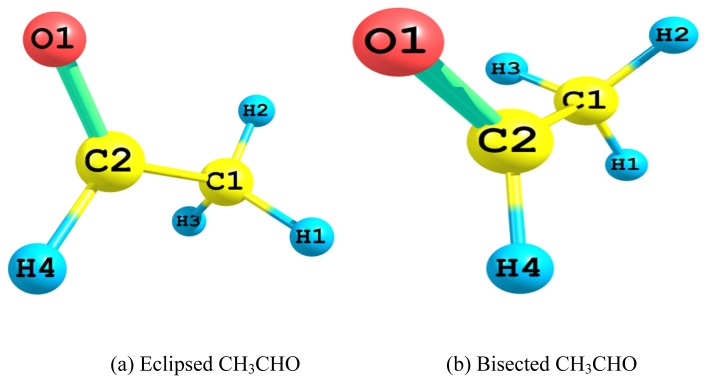
The atom type and labeling of Eclipsed and Bisected Acetaldehyde. (a) Eclipsed CH3CHO (b) Bisected CH3CHO